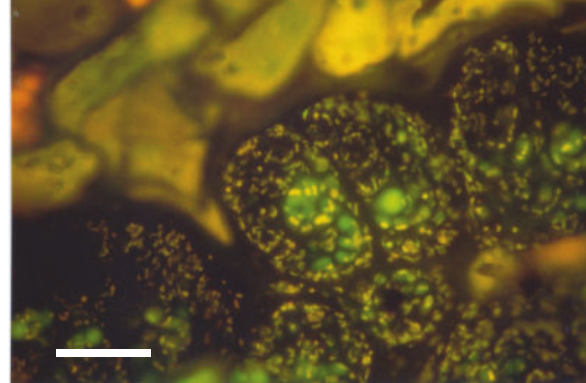
Fig. 4. Cross-section of a knot with bacterial zoogloeae (ar- row heads), surrounded by parenchymatic cells. Bar=500 μ m (fuchsin-Astra blue).